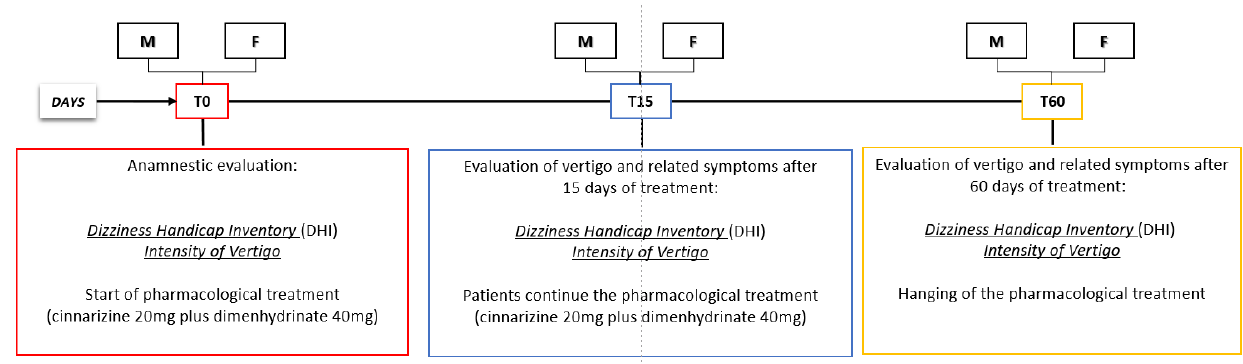
Figure 1. Timeline of the experimental procedures. M: male; F: female; T0: time at which the pharmacological treatment started; T15: 15 days after the beginning of the pharmacological treatment; T60: end of the treatment.